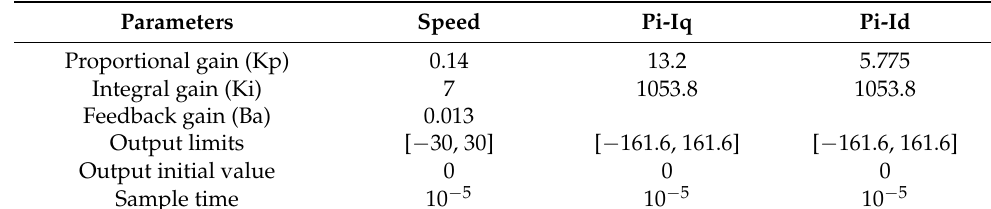
Table 1. Parameter setting of speed loop and current loop.